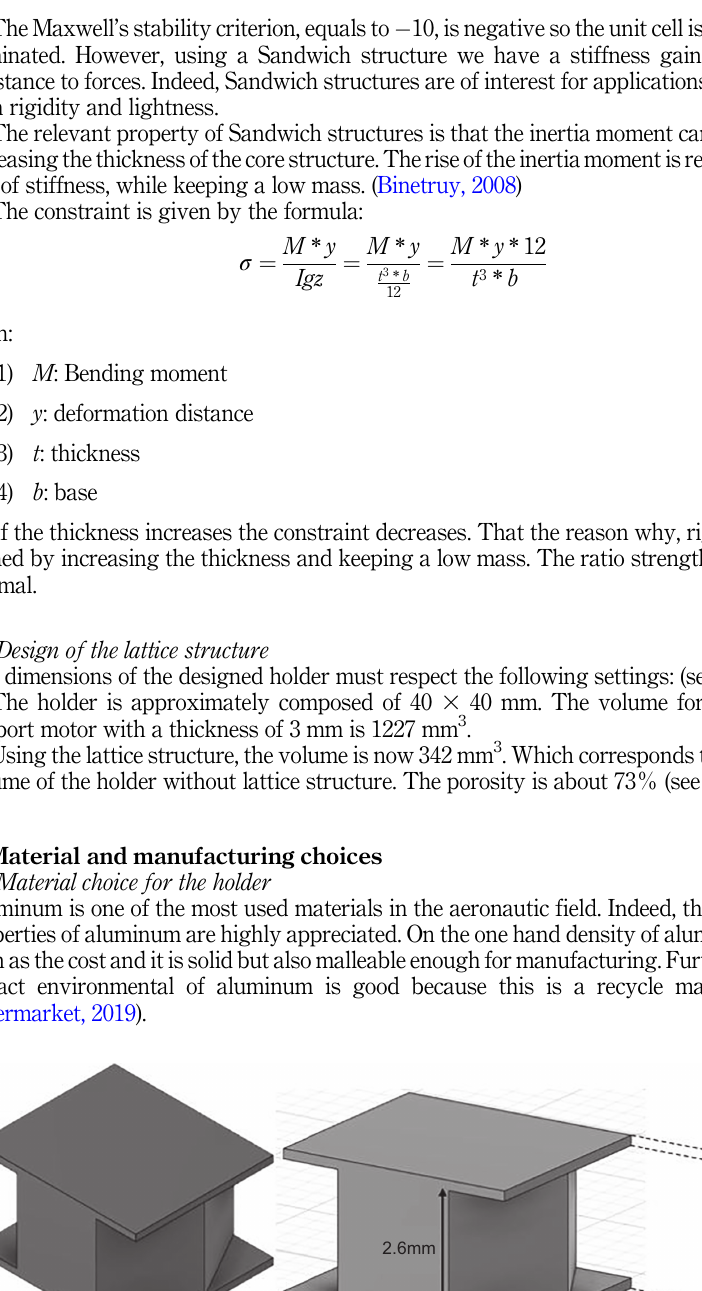
Figure 2. Dimensions of the